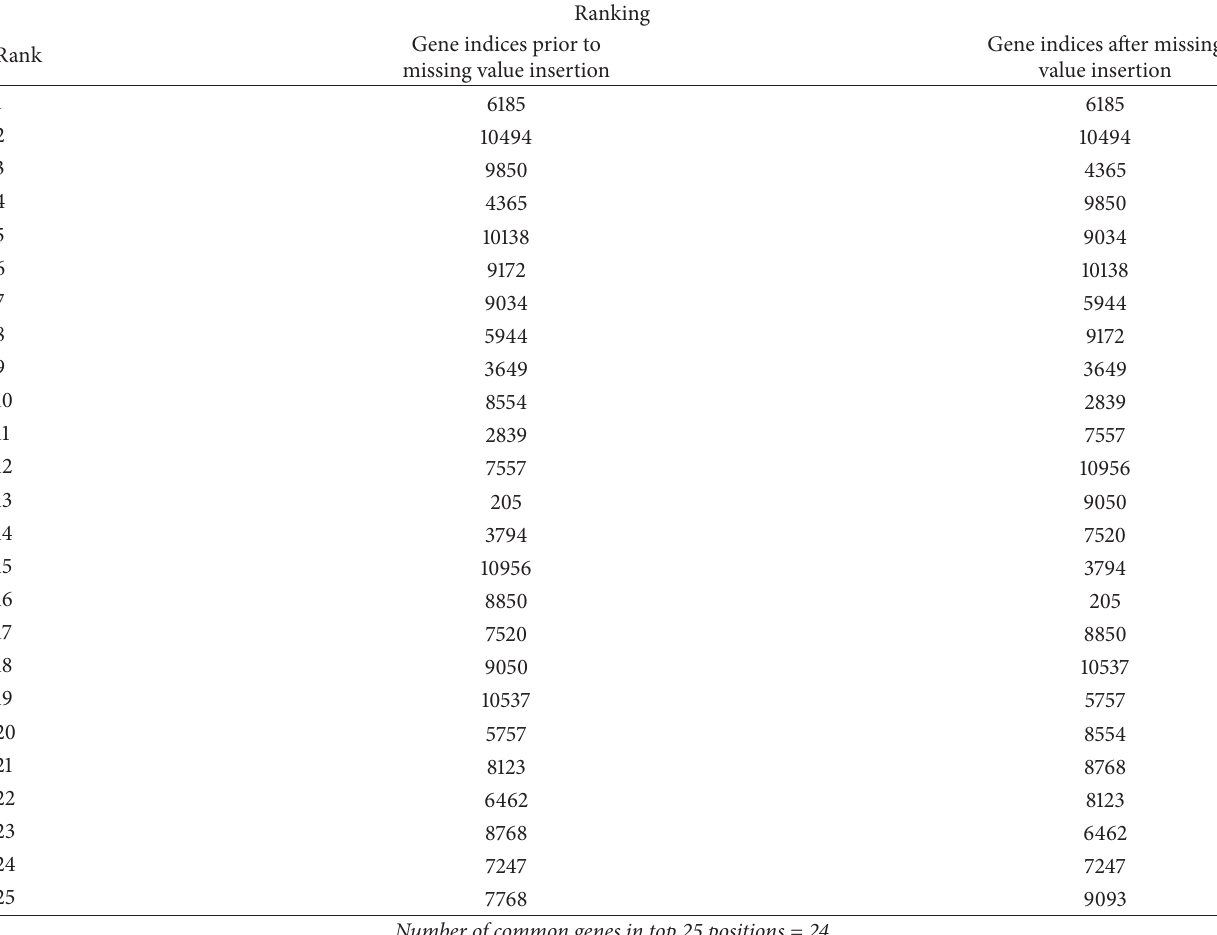
Table 11: Top 25 gene indices before and after estimation for Prostate Cancer dataset.